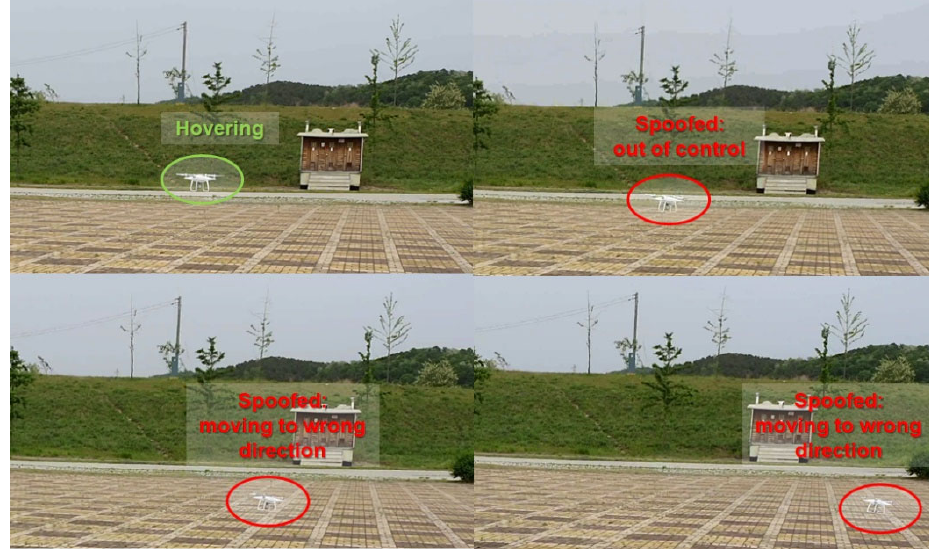
Figure 8. Test result of the Phantom drone.